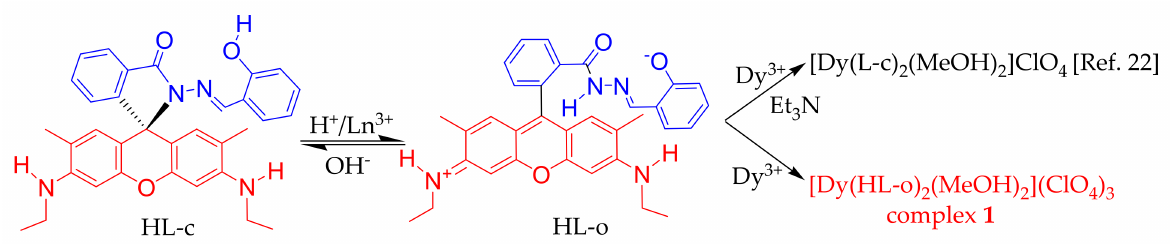
Scheme 1. Transformation of ring-closed and ring-opened form of rhodamine 6G salicylaldehyde hydrazone and its reactions with Dy 3+